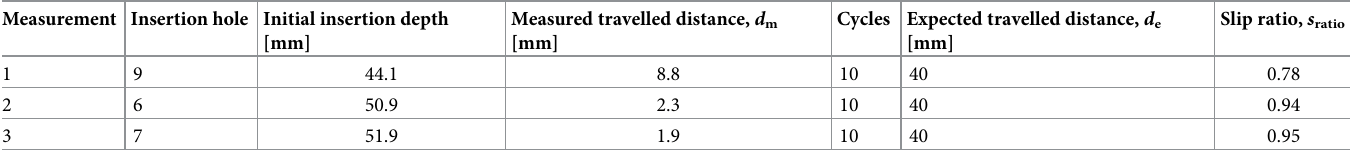
Table 1. Results of the ex vivo evaluation.